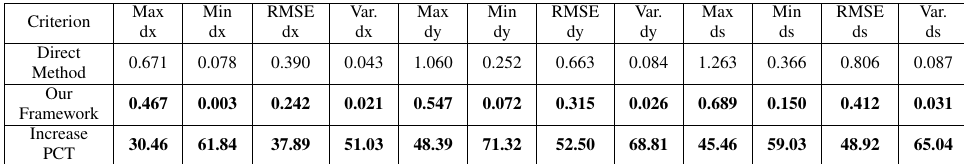
Table 3. Comparison of “direct method” and our framework in 19 cloud-free images. (Accuracy unit: pixel). Max dx, dy and ds are the max errors among all images in x-direction, y-direction and plane respectively, while Min dx, dy and ds are the opposite. Var. means the variance. Increase PCT is the percentage increase in our framework relative to the “direct method”. rix, while keeping spectral signatures of ground objects. And inpainting corrupted or damaged parts by low-rank component of that band.Some results are shown in Fig.11.